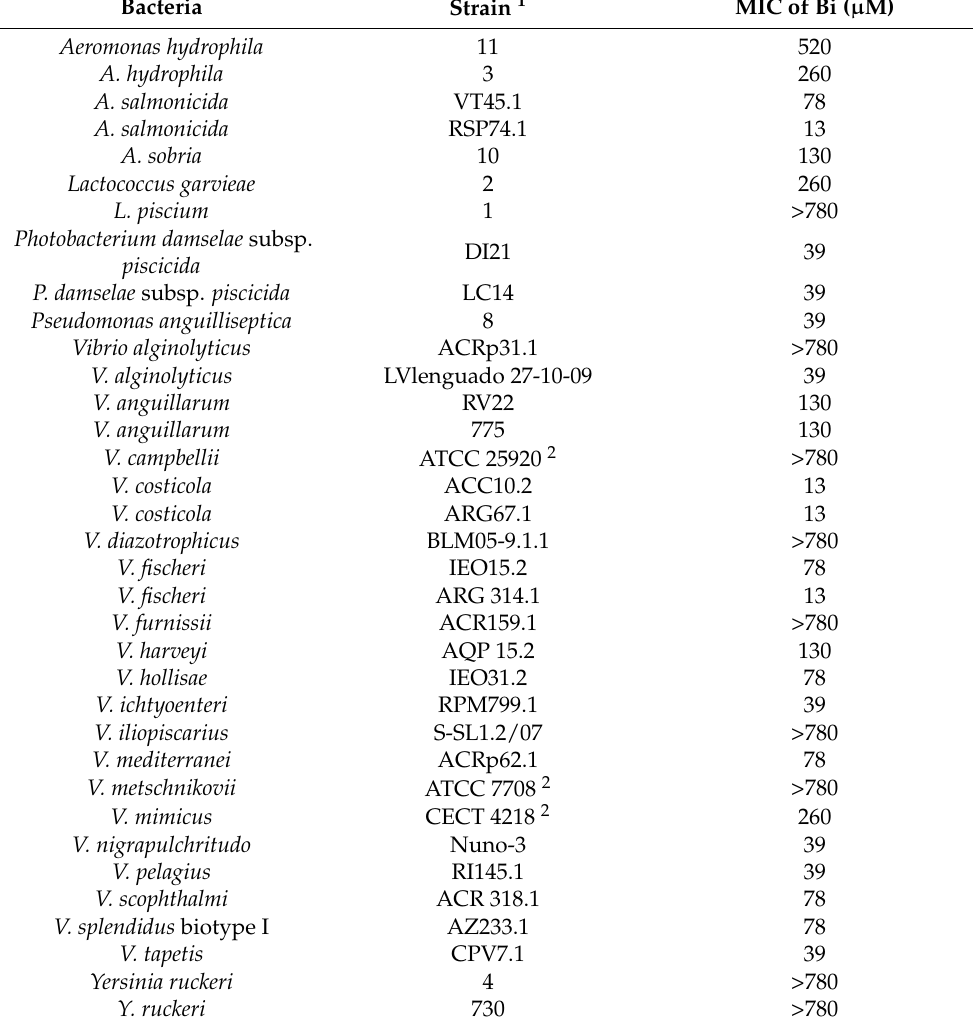
Table 1. Bacterial strains used in this work and minimal inhibitory concentrations (MIC) of Bi(III) ( µ M) for each